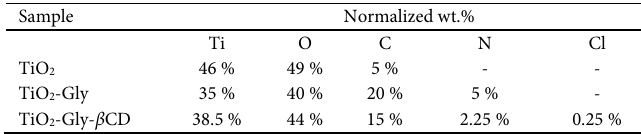
, TiO -Gly, and TiO -Gly- β CD. 2 2 2